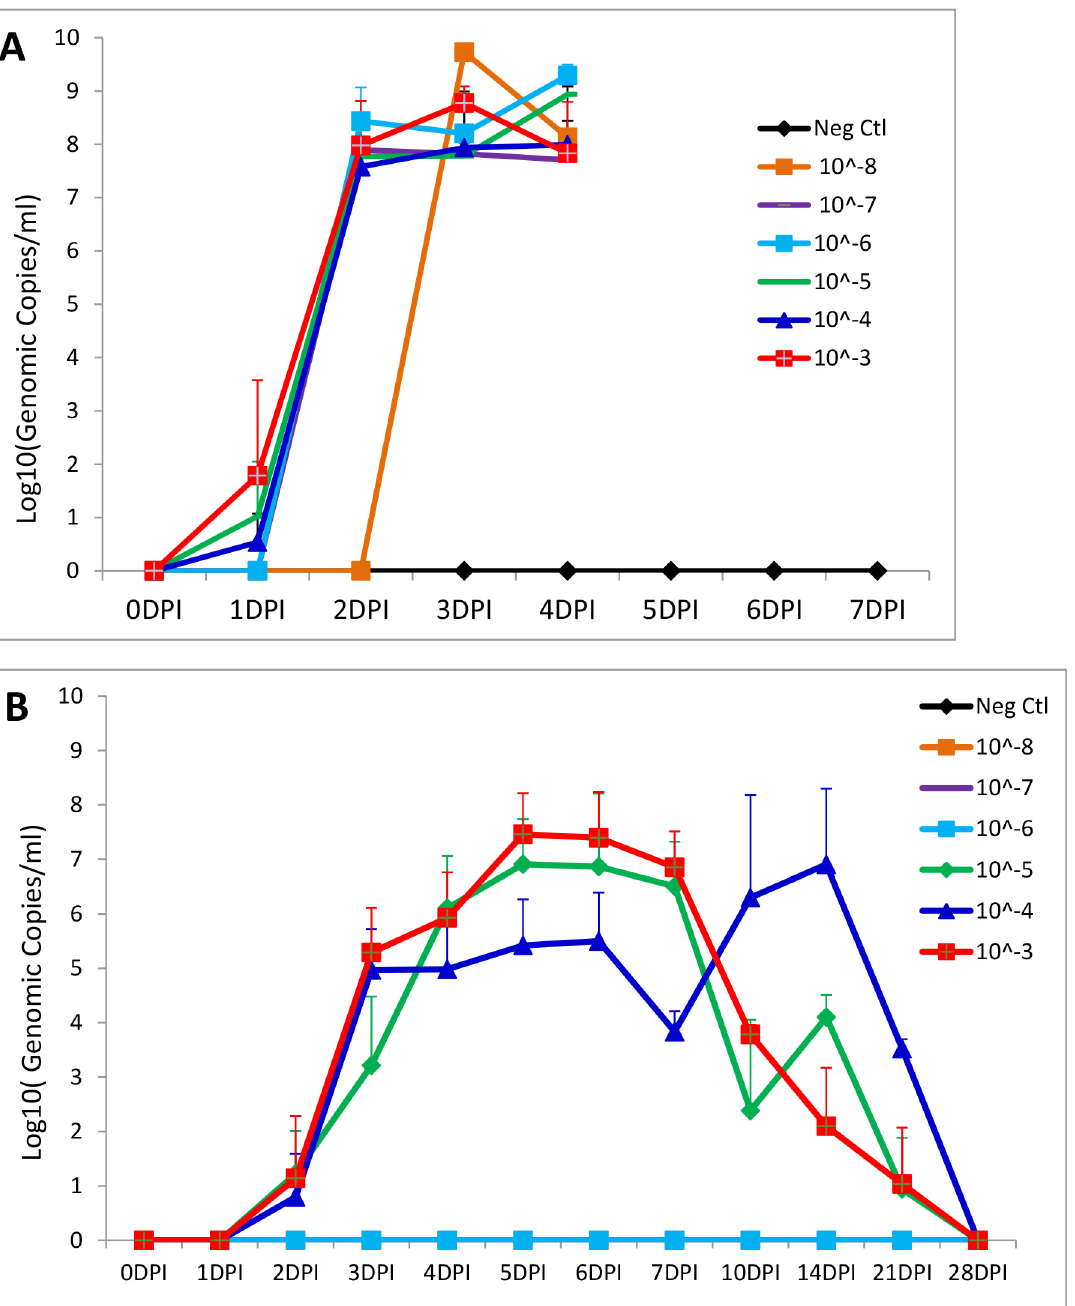
Fig 2. Virus shedding in rectal swabs of the 5-day-old pig study (A) and of the 3-week-old pig study (B) as determined by a quantitative PEDV N gene-based rRT-PCR. The virus titers (Log 10 Genomic copies/ml) at each time points were mean virus titers of all available pigs (both PCR positive and negative pigs) except the 10 − 8 group in the 5-day-old pig study where only one out of 4 pigs was positive in the study period and included in figure (A).